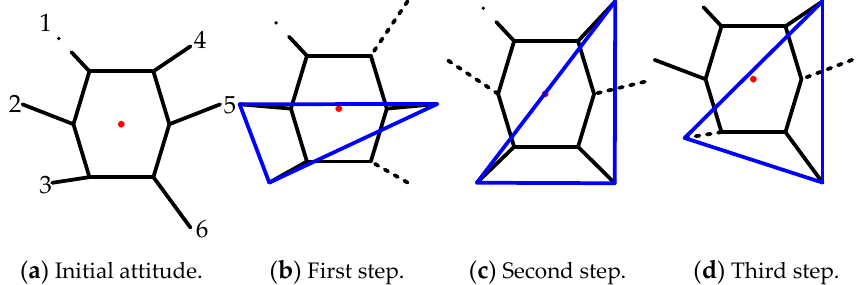
Figure 11. The method to obtain the adjusted angle.